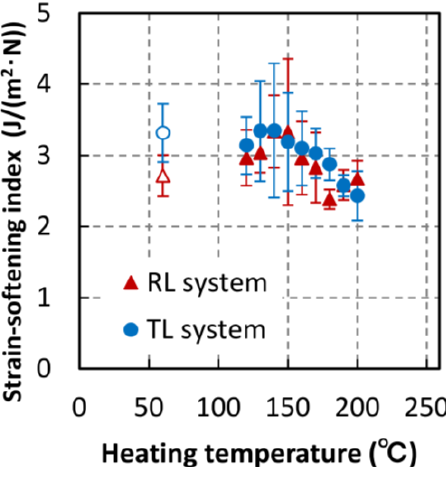
Figure 5. Strain-softening index obtained by dividing the fracture energy by the maximum